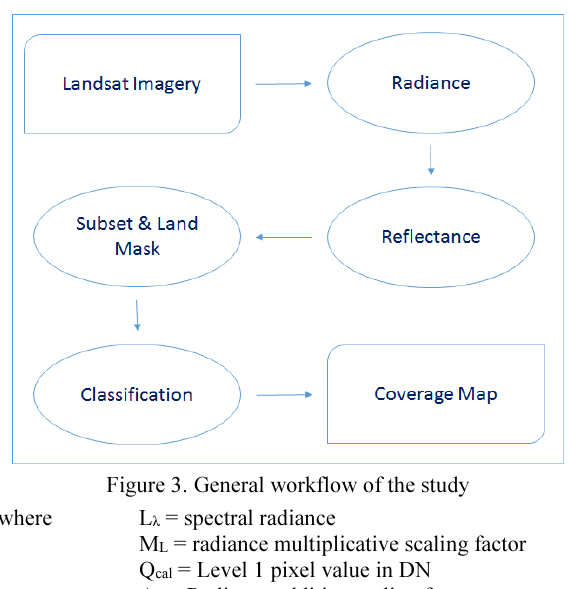
Figure 1. Study area